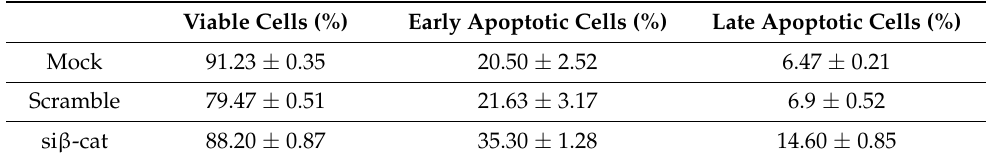
Figure 4. Inhibition of cell proliferation by siRNA-mediated β -catenin knockdown in chronic HCV-infected cells (d84). ( A ) Chronic HCV-infected cells were transiently transfected with β -catenin targeted siRNA for 4 days. Cell lysates were collected for Western blotting with indicated antibodies. Scrambled siRNA was used as the negative control. ( B ) Chronic HCV-infected and uninfected control cells were plated at densities of 3 × 10 5 cells/well in a 6-well plate and transfected with β -catenin siRNA. Cells were counted after 4 days using EVE Automated Cell Counter. Graph showed quantification of cell counted (mean ± SD, n = 3), *** p ≤ 0.001. ( C ) Apoptosis analysis by flow cytometry was performed for the chronic HCV-infected cells transfected with β -catenin siRNA on day 4. ( D ) Cell cycle analysis by flow cytometry was performed for the chronic HCV-infected cells transfected with β -catenin siRNA on day 4. Results are one trial representative of three independent experiments, * p ≤ 0.05. Table 1. Apoptotic analysis of cells treated by β -catenin-specific small interfering RNA